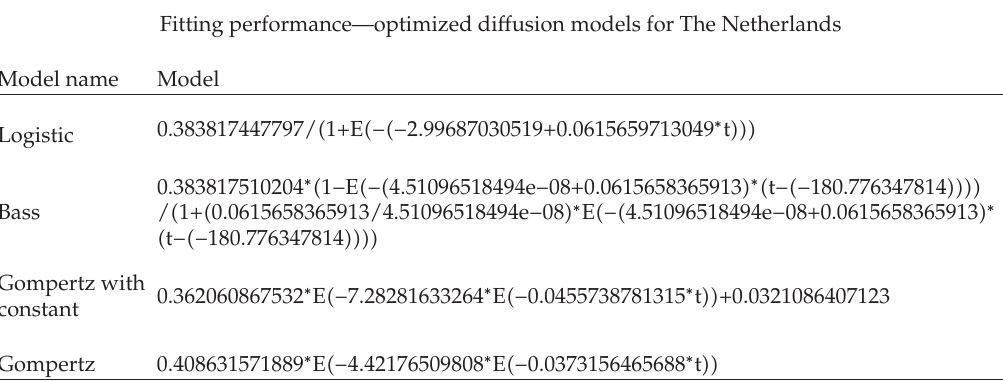
Table 26: Representation of the optimized di ff usion models in fitting (cid:2) The Netherlands (cid:3) . Fitting performance—optimized di ff usion models for The Netherlands